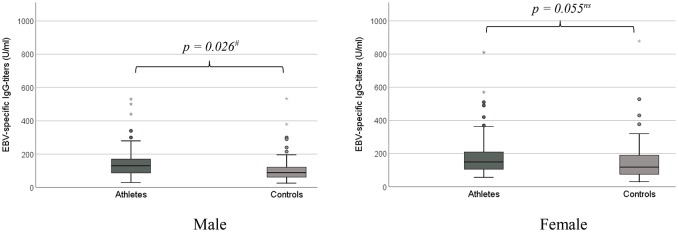
EBV-specific IgG-titers (U/ml) in comparison between athletes and controls. (A) male subjects. (B) female subjects. #p < 0.05. *Extreme value (defined as a value that is smaller (or larger) than 3 box-lengths).